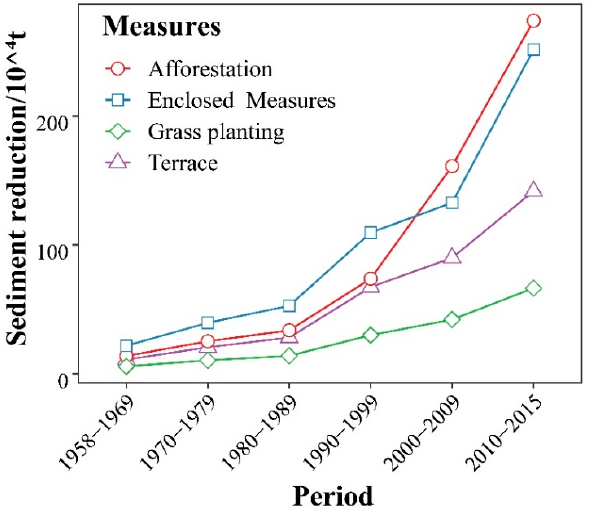
Figure 13. Sediment reduction by slope measures over various periods in the QRB.